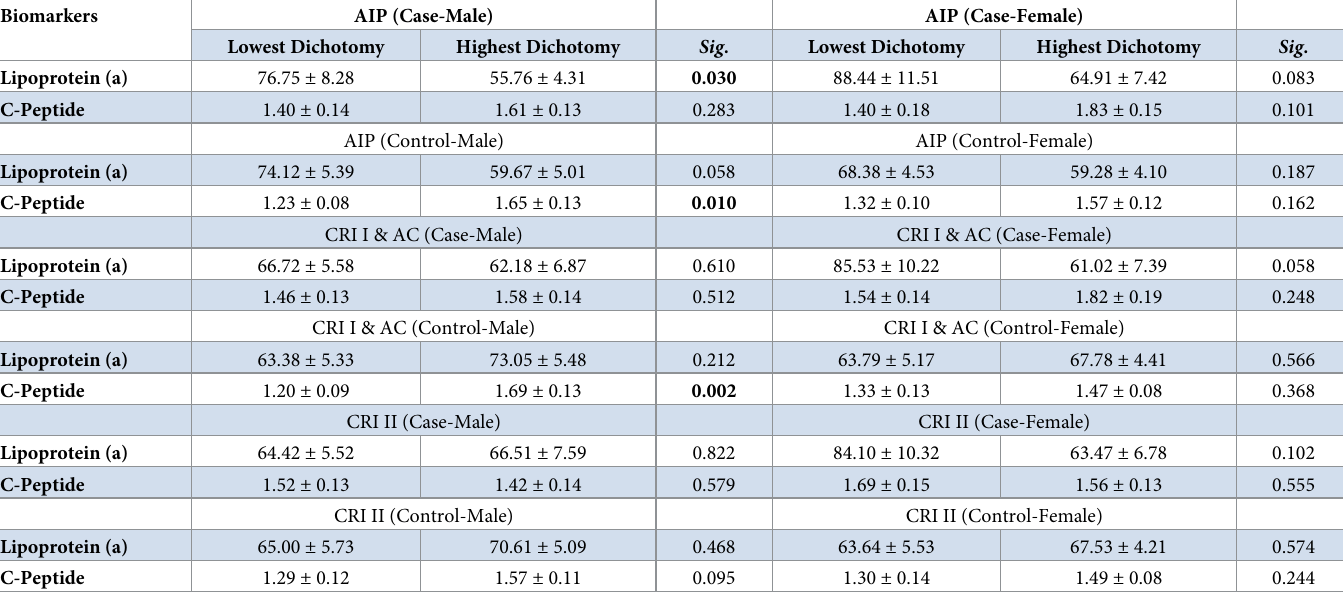
Table 2. Mean ± SE � serum lipoprotein (a) and C-Peptide levels‡ in lower and upper dichotomies of atherogenic indices of plasma¶ according to gender.